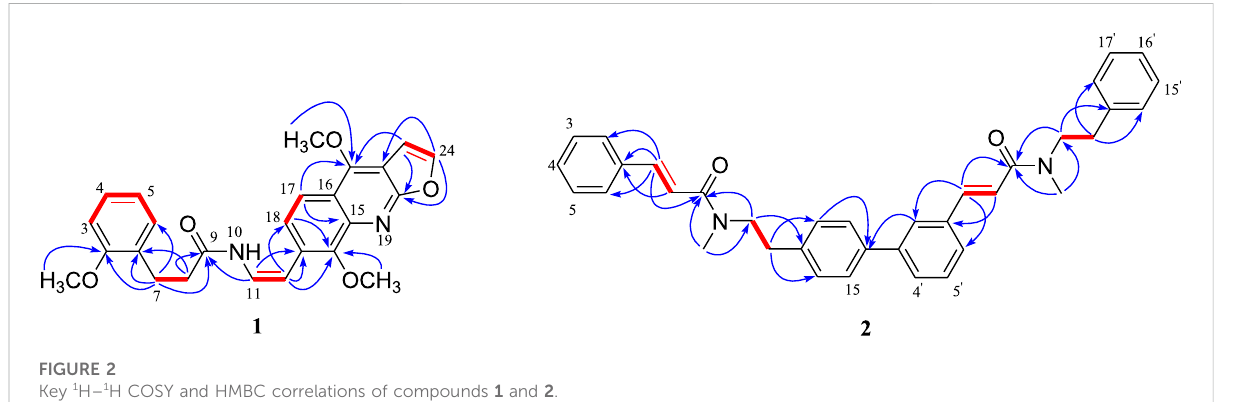
FIGURE 2 Key 1 H – 1 H COSY and HMBC correlations of compounds 1 and 2